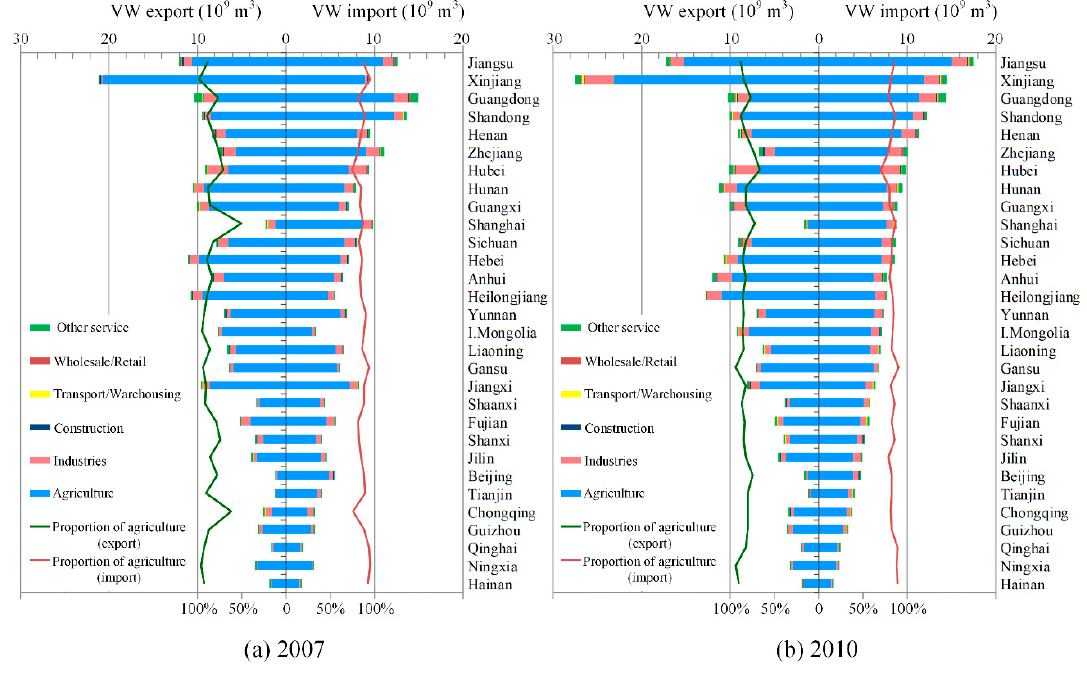
Figure 3. Sectoral composition of VW in 30 regions of China for the years, 2007 and 2010.